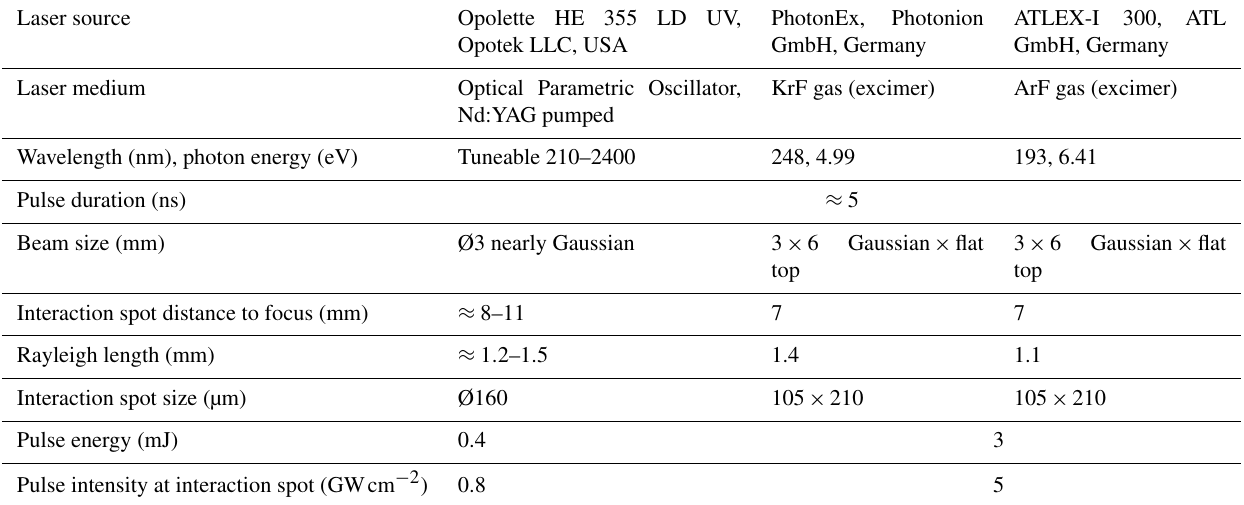
Table 1. Light sources and details of the optical